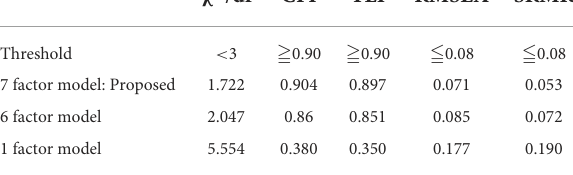
TABLE 2 Confirmatory factor analysis results for the measures of all